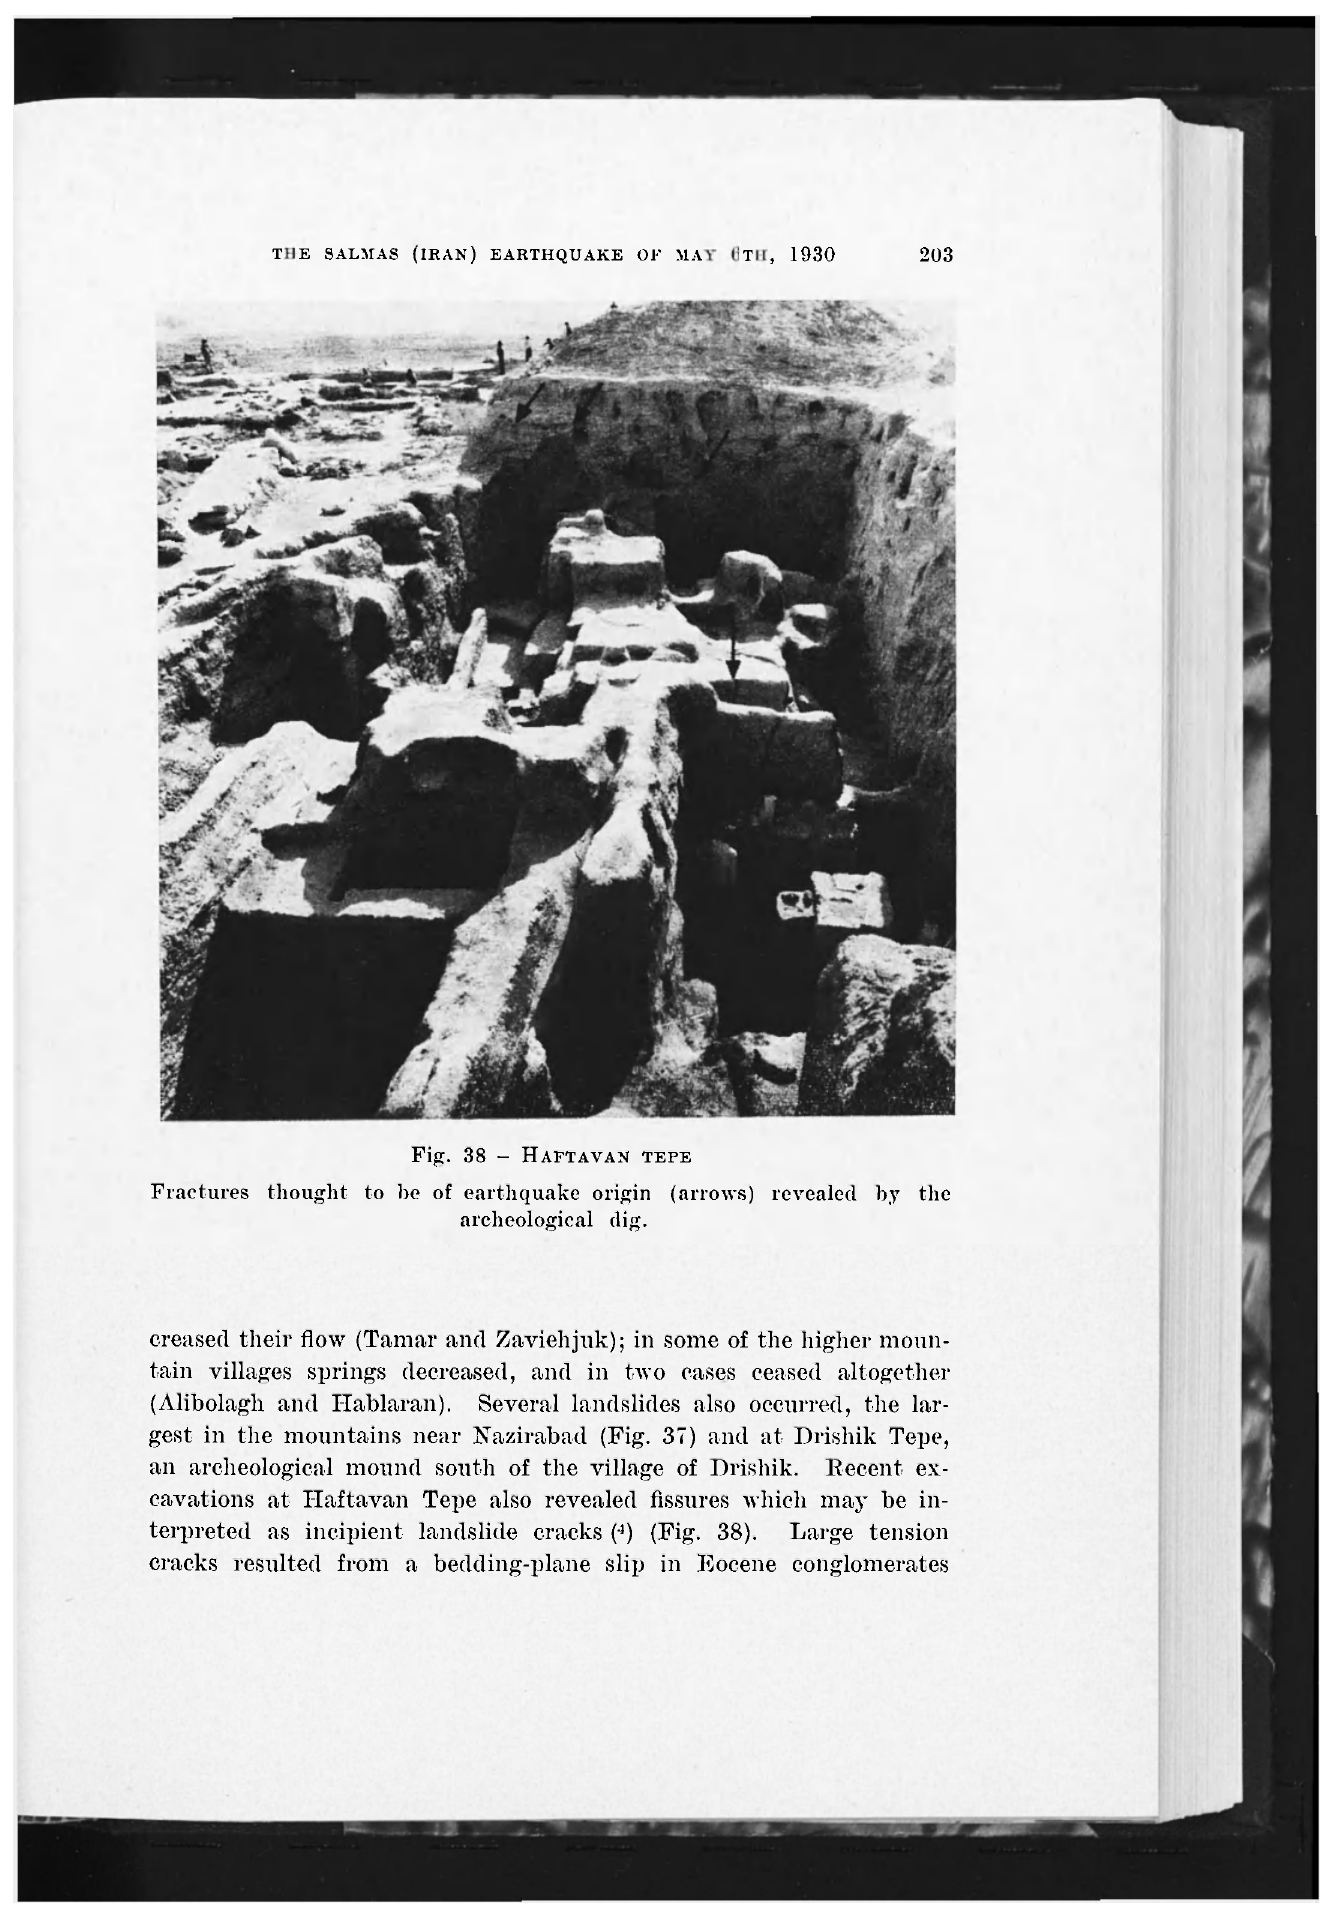
TIIE SALMAS (IRAN) EARTHQUAKE OF MAY ÖT1I, 1930 203